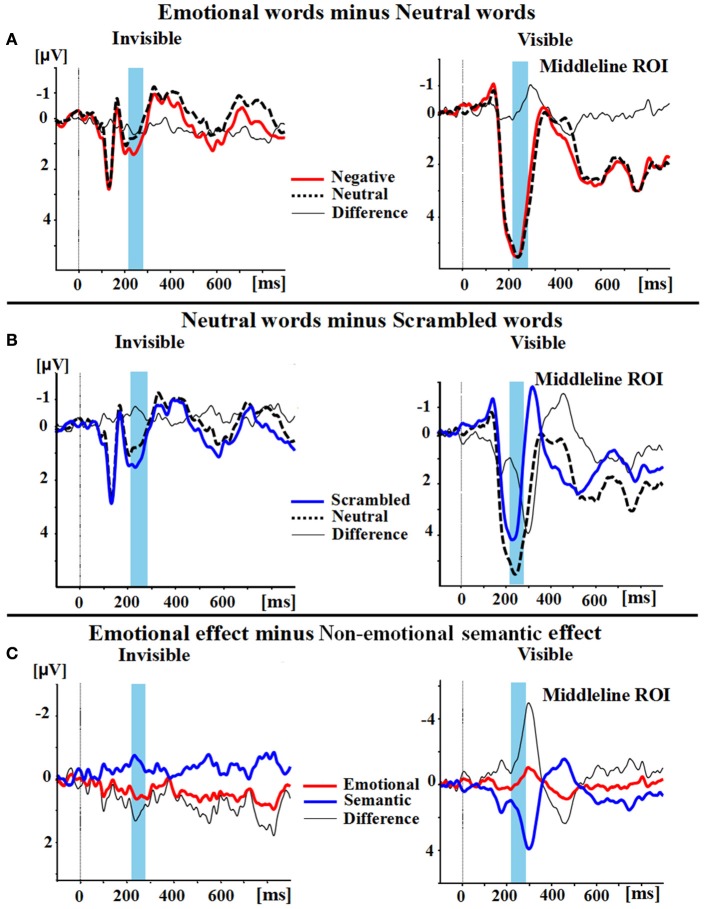
Group Average differences in wave amplitudes from 220 to 280 ms. (A) Emotional effect: the P2 amplitudes of negative words (red line) minus the amplitudes of neutral words (black dotted line); the difference wave is represented as a thin black line. (B) Semantic effect: the P2 amplitudes of neutral words (black dotted line) minus the amplitudes of scrambled words (blue line); the difference wave also is again represented as a thin black line. (C) The difference wave (thin black line) between the emotional effect (red line) and the semantic effect (blue line).